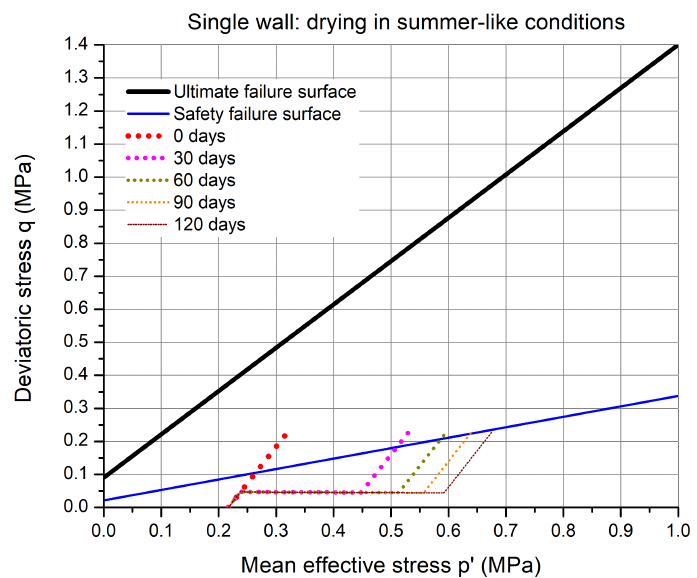
Figure 12. The stress path in the p (cid:48) – q plane for the critical point in the wall at different duration of drying in summer-like environmental